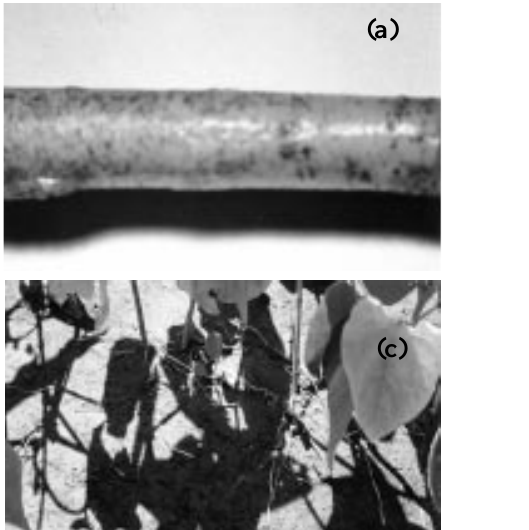
- Testemunha (a) e no T - Elevação gradativa do 1 4